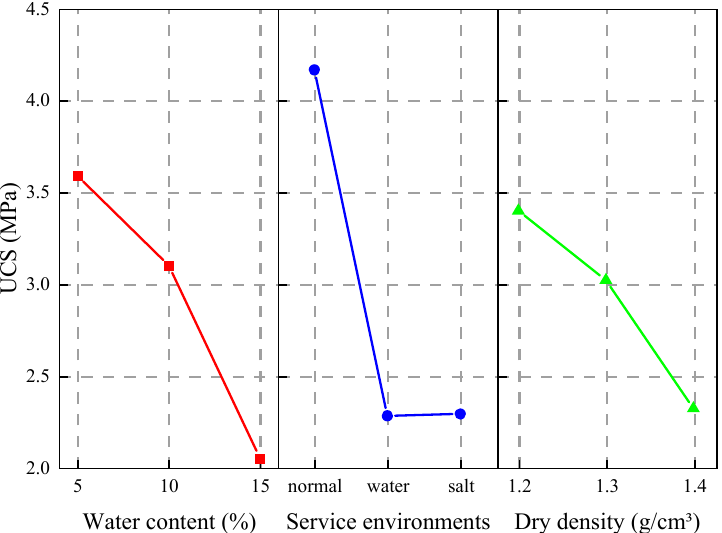
Figure 8. Influence trend of various factors on compressive strength.